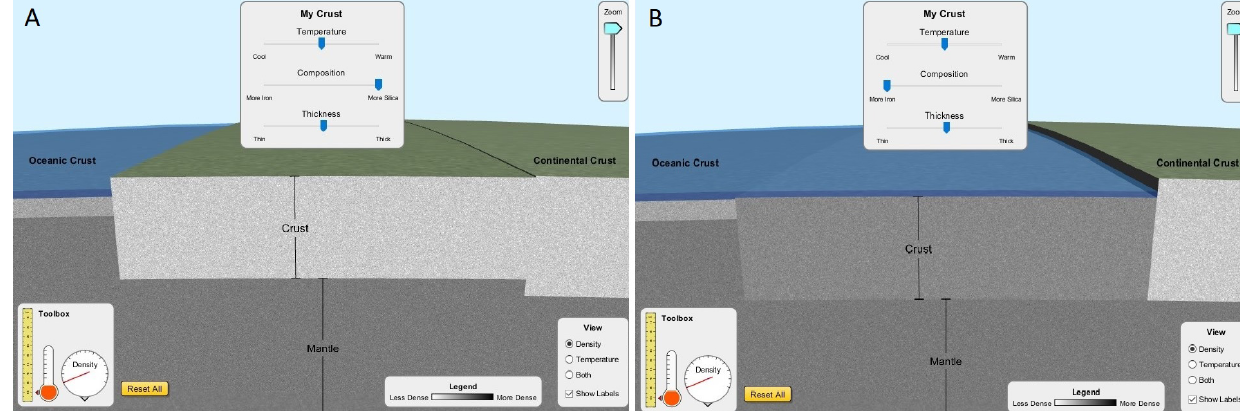
Figure 3. Comparison between the movements of a crust that is richer in silica (a) and a crust that is richer in iron (b) . Caption from PhET™ Plate